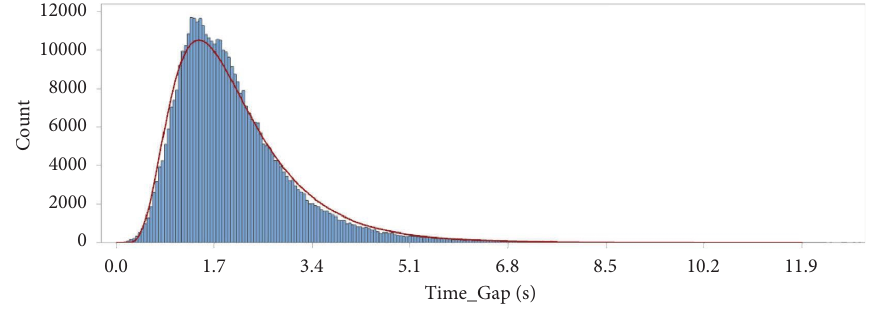
Figure 3: Distribution of time gap in